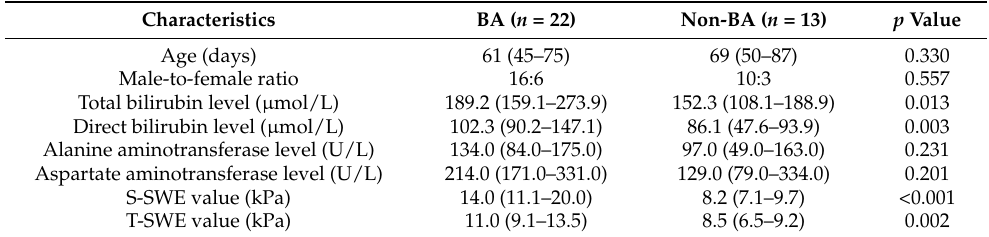
Table 1. Baseline characteristics at time of shear wave elastography measurements in pediatric patients with conjugated hyperbilirubinemia.